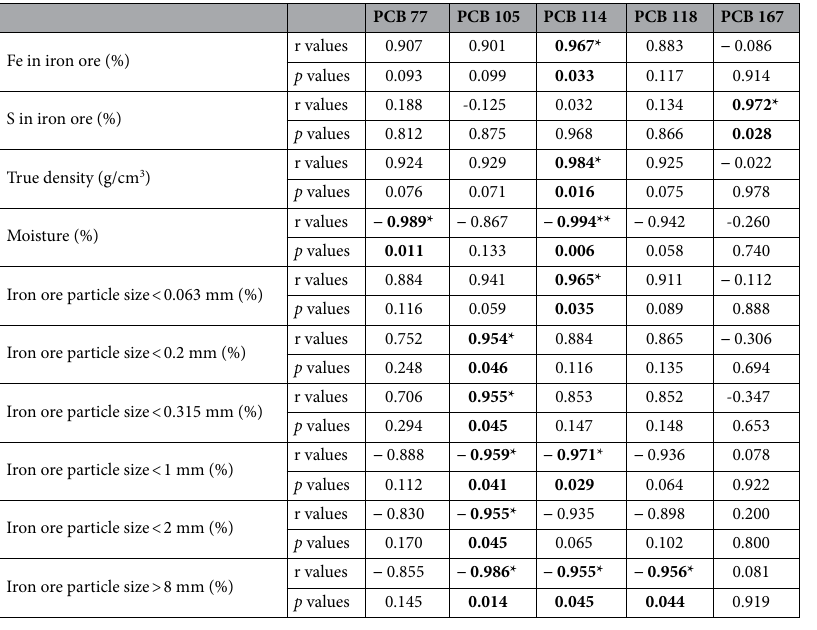
Table 4. Statistical correlations between iron ore properties and concentrations of PCB congeners (WHO- TEQ ng/g) in dust samples. **Correlation is significant at the 0.01 level (2-tailed). *Correlation is significant at the 0.05 level (2 tailed). Significant values are in